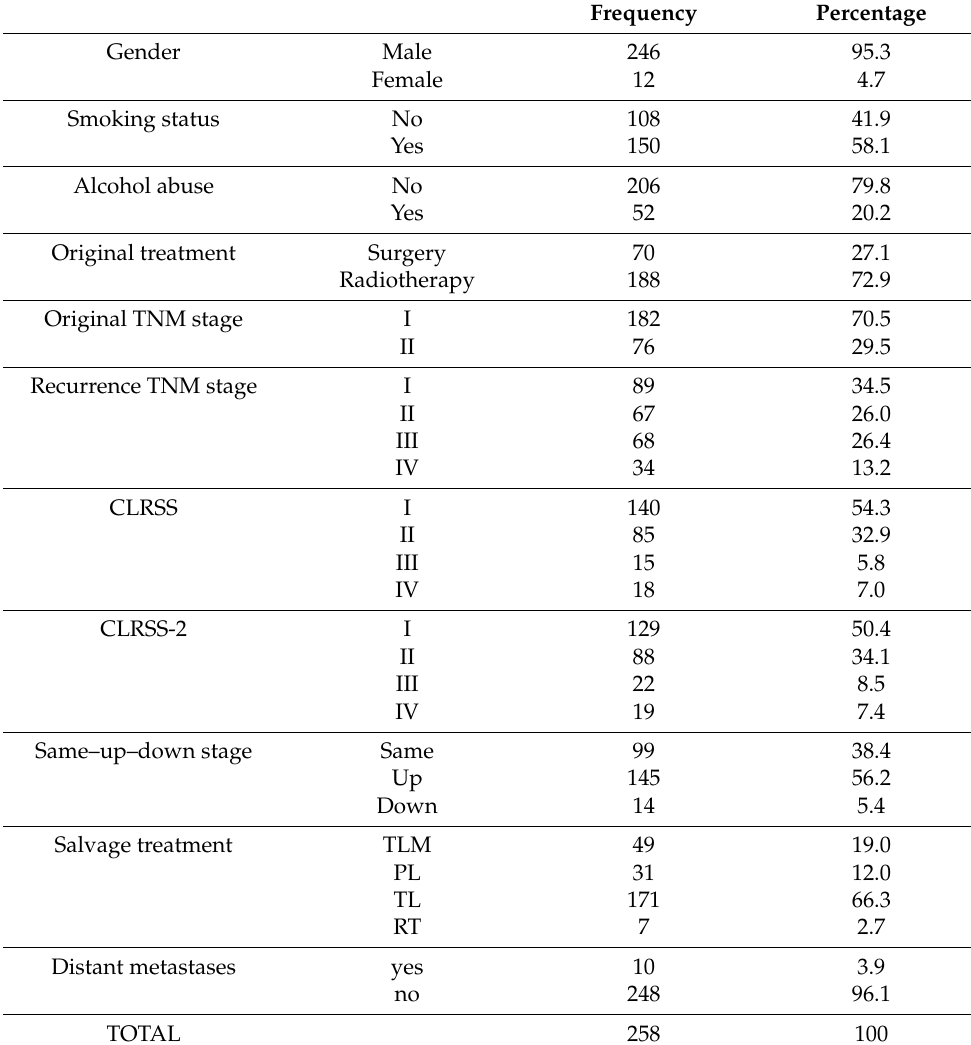
Table 1. A general descriptive analysis of the variables analyzed in our